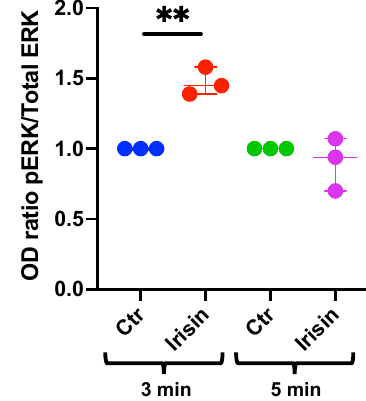
Figure 2. Effects of irisin on pERK in differentiated DBSCs. DBSCs, differentiated in osteogenic medium for 10 days, were stimulated with irisin for 3 or 5 min. pERK and total ERK expression levels in cell lysates were examined by Western blot and measured with corresponding densitometric quantification. Densitometric analysis is expressed as the relative optical density (OD) of the bands normalized to total ERK. The graph shows that the treatment significantly increased the protein expression level of pERK after 3 min of stimulation. The graph represents data as a boxplot with median and interquartile ranges of n = 3 independent experiments. ** p < 0.01. Statistics: unpaired Student’s t -test.